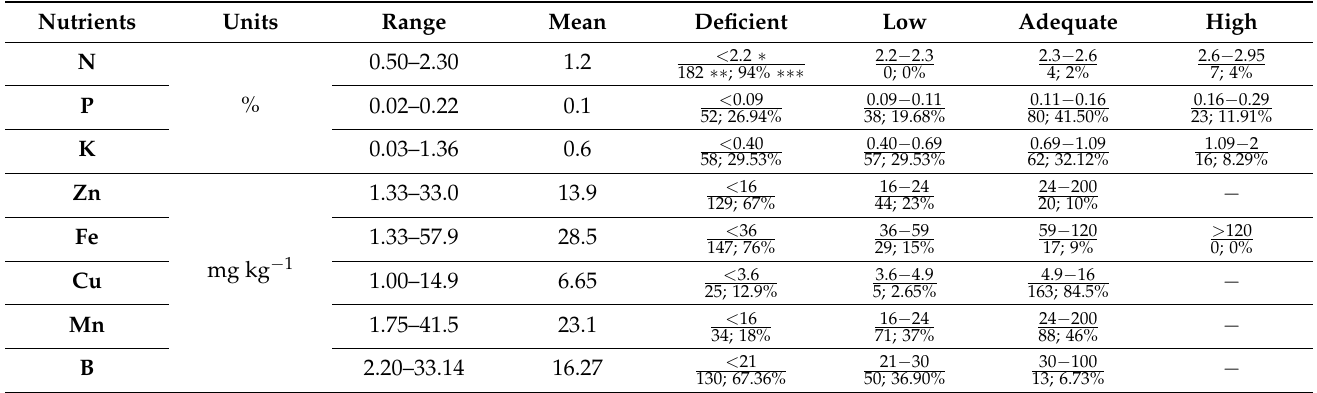
Table 5. Summary of data showing the concentration of macro (%) and micronutrients (mg kg − 1 ) in leaves of citrus trees situated in Layyah district. There were 48 sites at which sampling was performed. Means are an average of 3